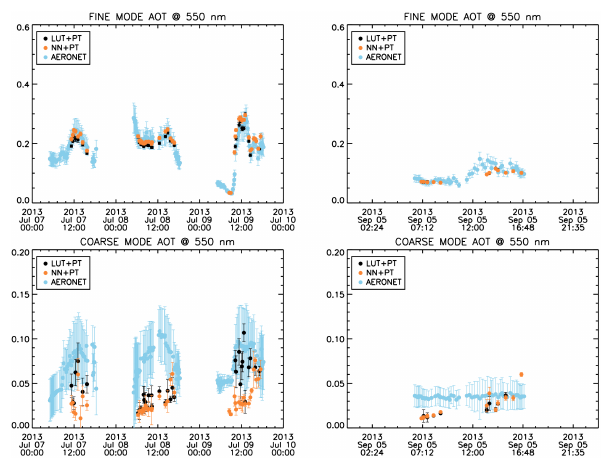
Figure 8. Time series of the fine- (above) and coarse-mode (be- low) AOT retrieved by the LUT + PT scheme (black circles), the NN + PT scheme (orange circles), and the AERONET SDA level 1.5 product (sky-blue circles): between 7 and 9 July 2013 (left) and on 5 September 2013 (right).